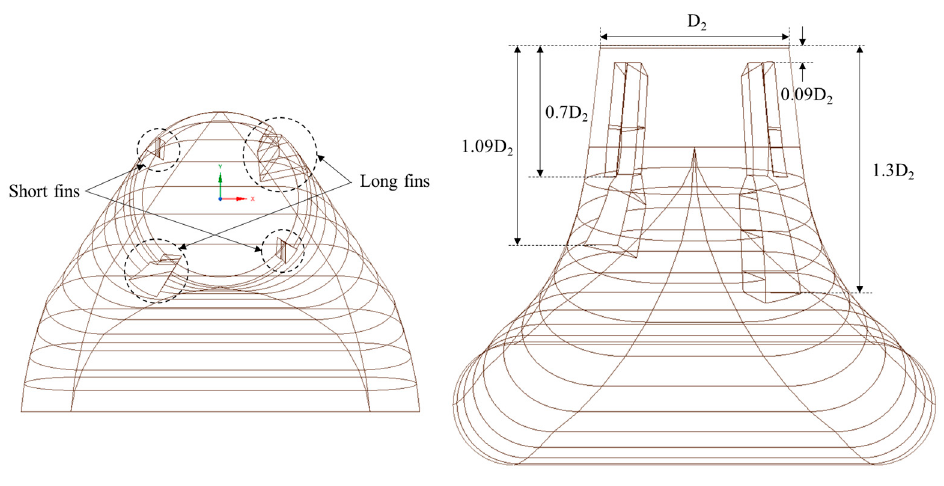
Figure 1. Location of the anti-swirl fins in the DT of the Francis turbine